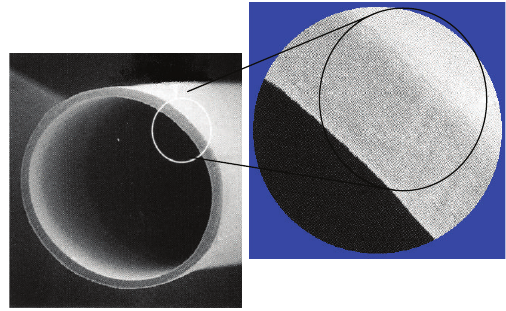
Figure 2: The scanning electron microscopy findings of cross- sectional structure of CTA. The cross-sectional structure of CTA shows uniform structure in which pore size from inside (blood side) to outside (dialysate side) the hollow fiber is